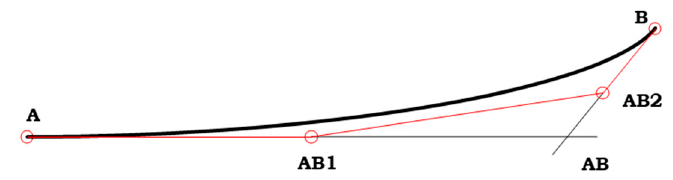
Figure 4. Degree elevation of a rational Bézier curve.